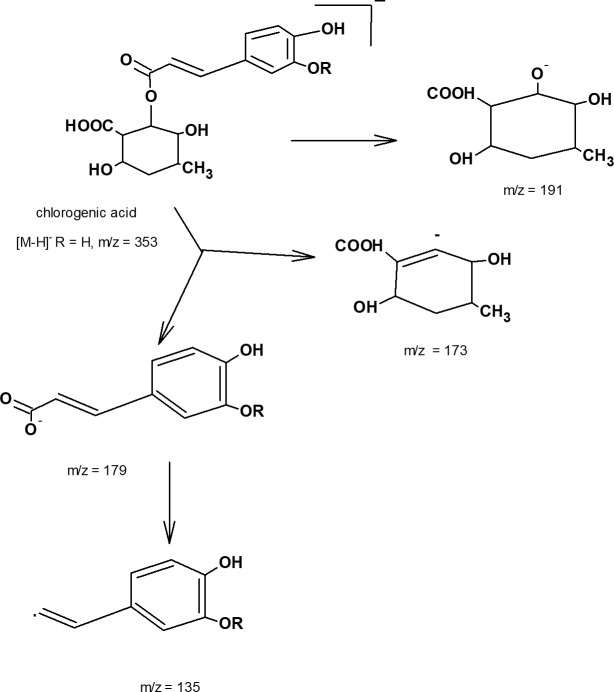
Fragment pattern for chlorogenic acid in MS/MS.